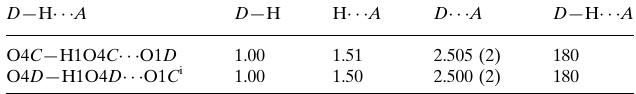
Hydrogen-bond geometry (A˚ , (cid:3)